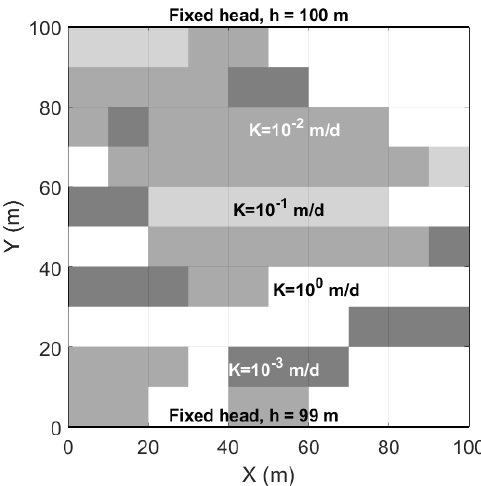
Figure 4. Conceptual model of the second test problem. Groundwater is flowing between two fixed head boundaries, through a heterogeneous porous medium. The hydraulic conductivity distribu- tion spans four orders of magnitude.